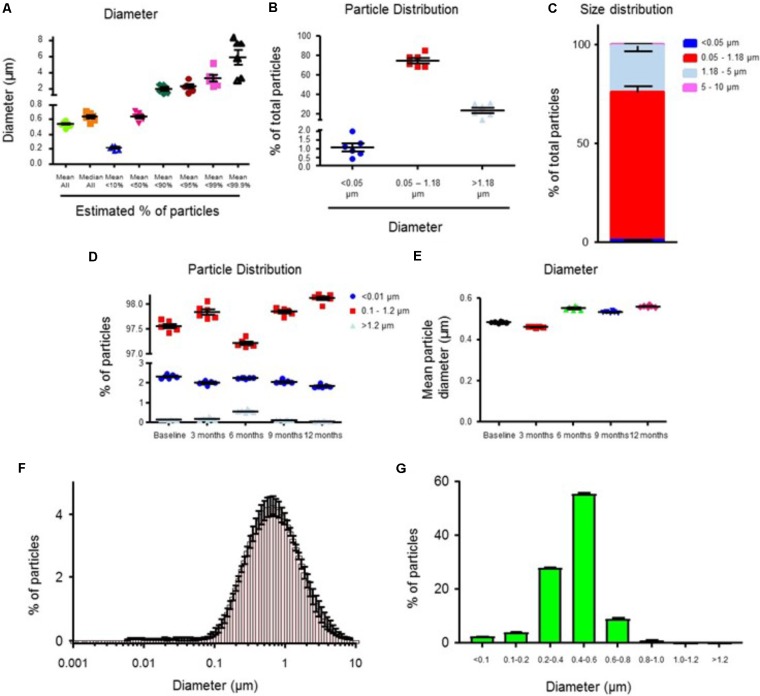
The size distribution of RMPs when analyzed using DELSATM Nano analyzer (A–C) and flow cytometry (D,E) methods. (A) Mean (all), median (all), and maximum diameter of RMP populations (smallest 10, 50, 90, 95, 99, and 99.9%) (n = 6). (B) Particle size distribution as a percent of total size (<0.05 μm, 0.05 – 1.18 μm, >1.18 μm) (n = 6). (C) Percent of particle distribution in the four size groups (<0.05 μm, 0.05 – 1.18 μm, 1.18 – 5 μm, and 5 – 10 μm) (n = 6). (D) The size distribution (% of total) of RMPs when analyzed using flow cytometry (n = 6). (E) Mean particle diameter (μm) in samples stored at –20°C for the duration of 0 (n = 6), 3 (n = 6), 6 (n = 6), 9 (n = 6), and 12 months (n = 6). The size distribution curves of RMPs when analyzed using DELSATM Nano analyzer (F, n = 6) and flow cytometry methods (G, n = 6).